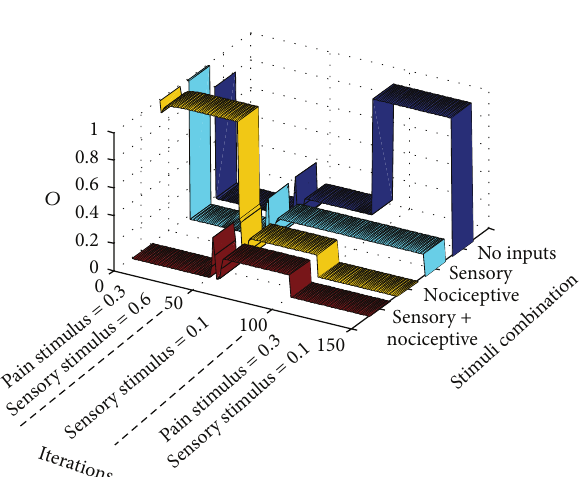
Figure 11: Modeling wind-up pain. After 50 iterations with standard training epochs, signals from mechanoreceptors become weak but repetitive, without any other type of stimulation. This situation is modeled from iterations 50 to 100 in which the gate circuit, instead of receiving different stimuli like in previous cases, only receives a repetitive weak sensory stimulus. For understanding pain responses to other types of stimuli during the phase of repetitive weak sensorystimulation,alltypesofplasticity(synapticandintrinsic)are blocked from iterations 100 to 150 (as done in previous example). As can be seen, after a prolonged weak sensory stimulation, the circuit relays a pain output in the case of no stimulation (between periods of weak sensory